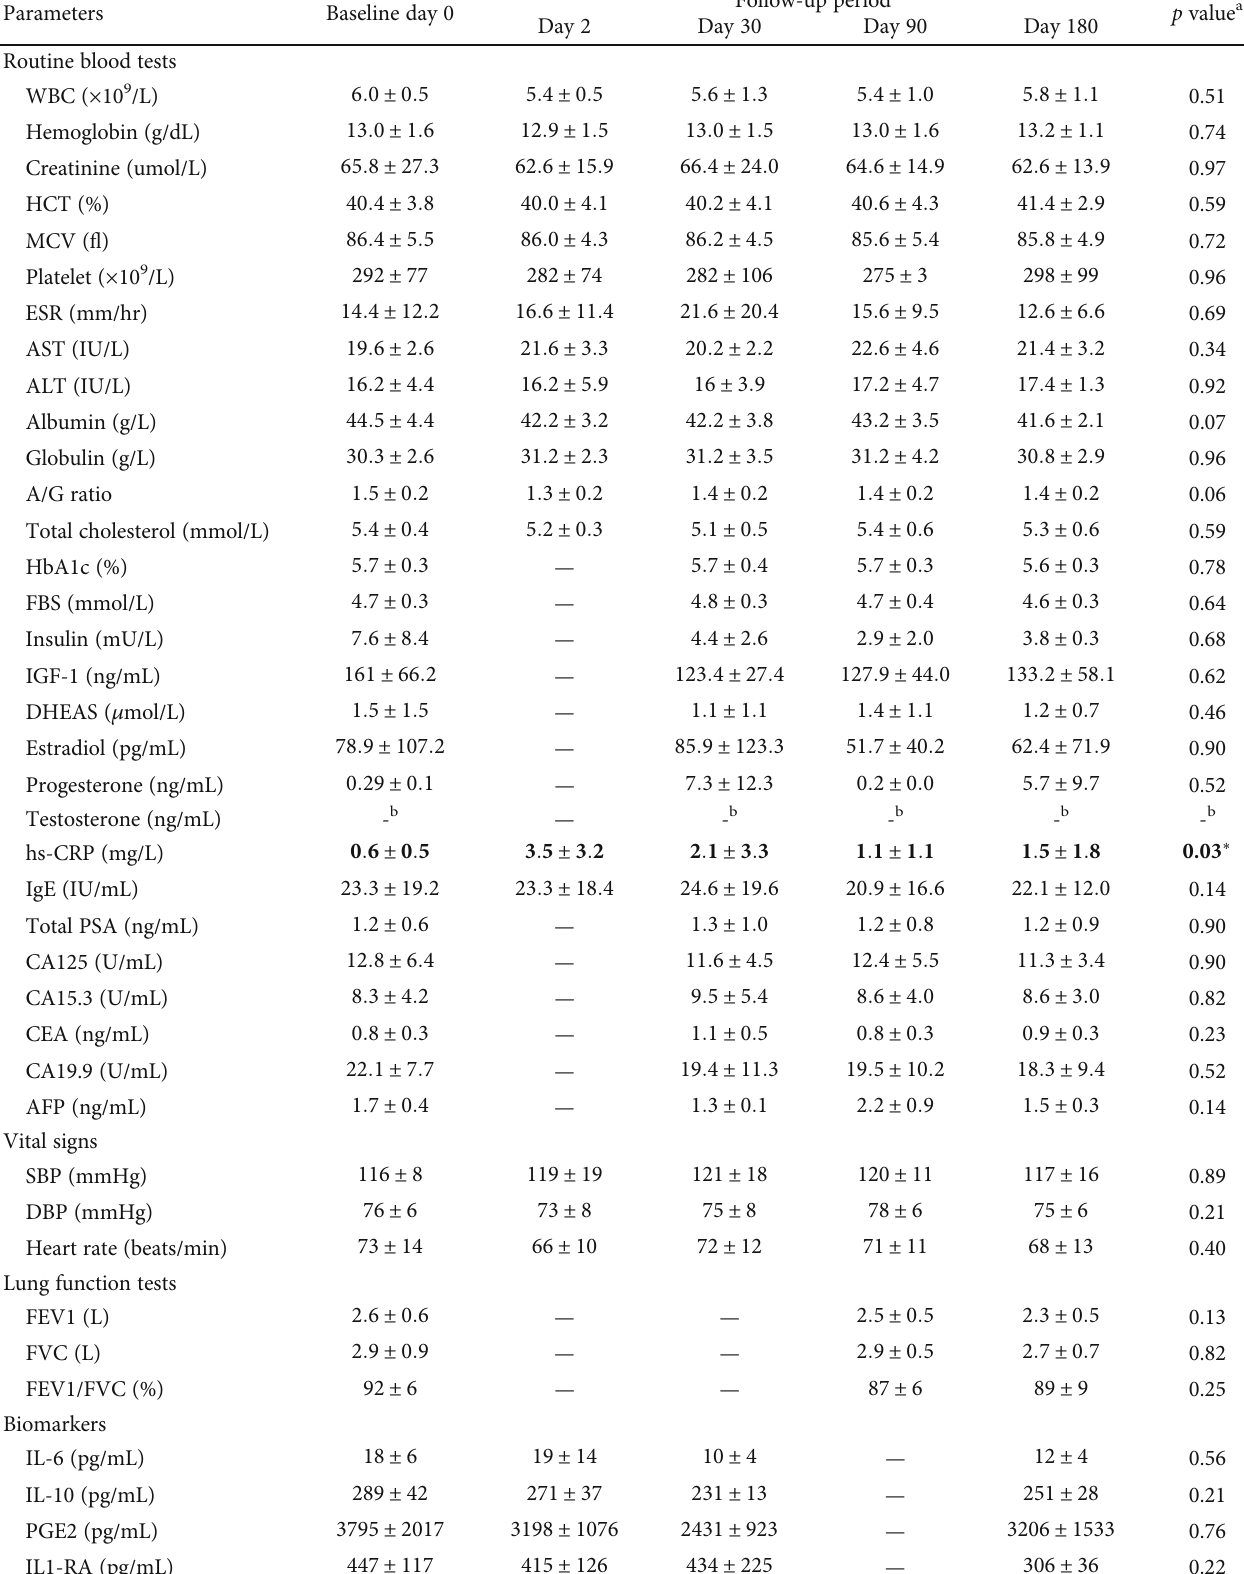
Table 3: Baseline and follow-up clinical assessments among subjects in the LD